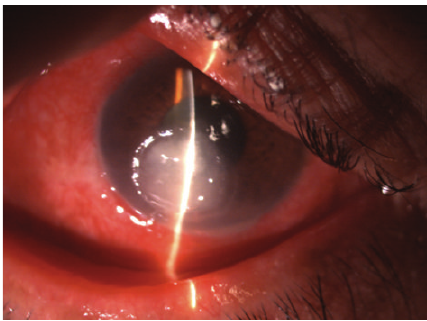
Figure 1: Day 11 since initial examination.